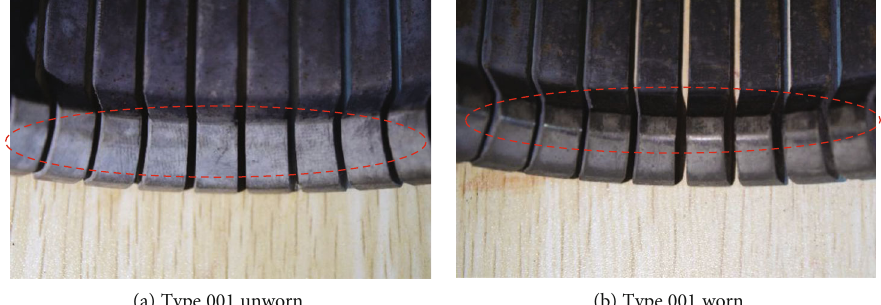
Figure 14: Real object comparison of type 001 between unworn and worn.